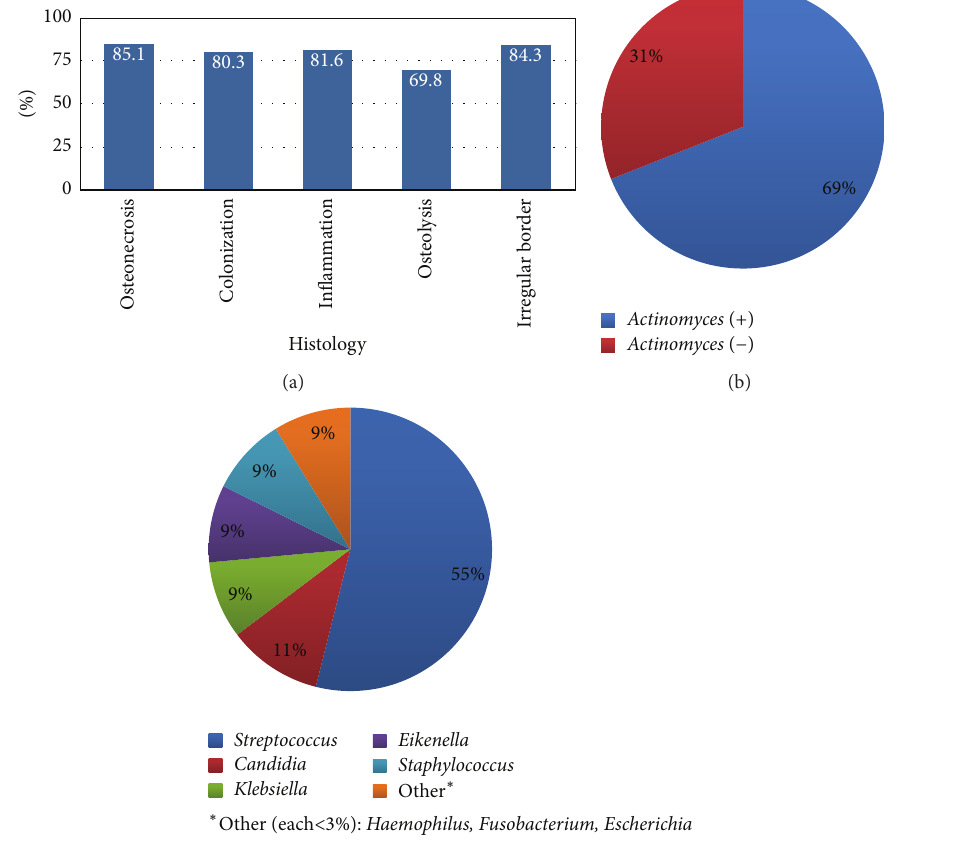
Figure 3: Histological results (a), microscopic identification of Actinomyces by H&E, Gram, and/or PAS stains (b), and culture results excluding Actinomyces